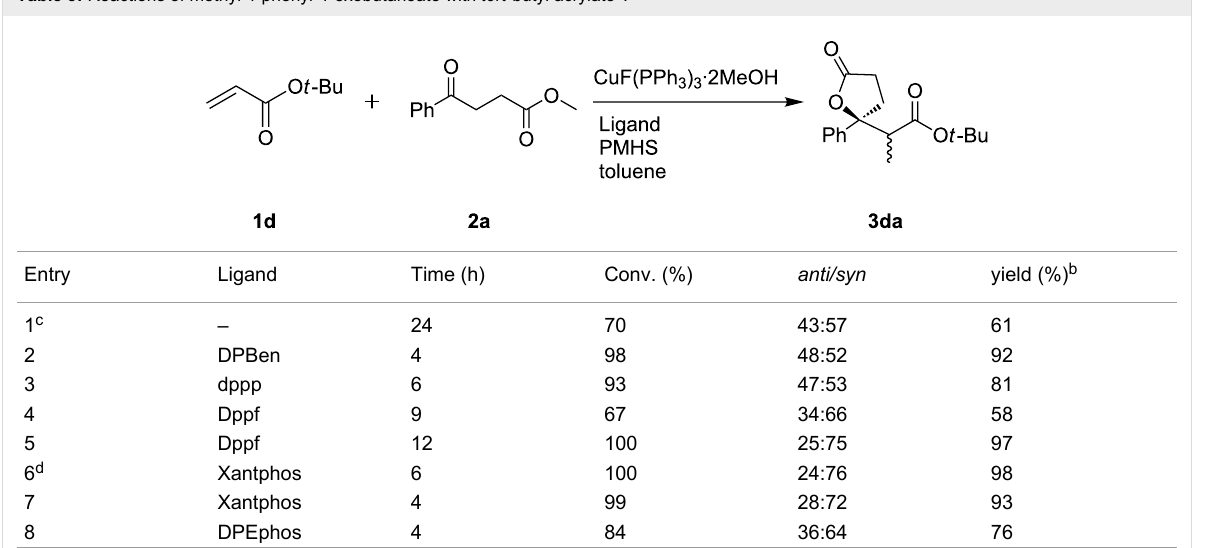
Table 3: Reactions of methyl 4-phenyl-4-oxobutanoate with tert -butyl acrylate a .